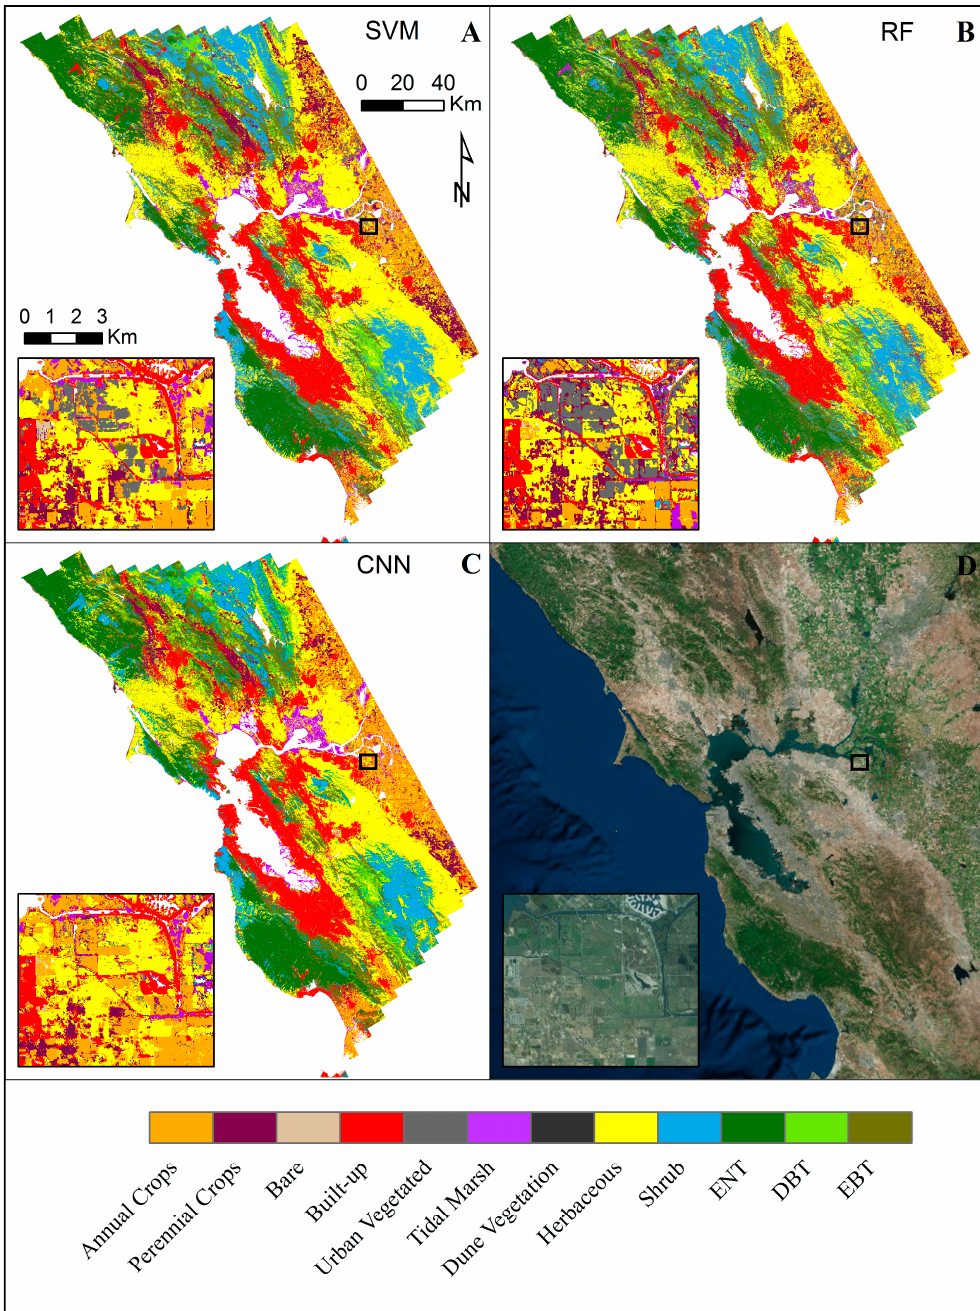
Figure 8. Classified land-cover maps for ( A ) Support Vector Machine; ( B ) Random Forests; and ( C ) Convolutional Neural Networks. White areas indicate pixels that were not classified (e.g., water, clouds, no data); ( D ) Natural color mosaic of imagery from June 2015. The insets show an example of the classifications in the Bay Area delta agricultural zone. This area is predominantly agricultural land with some urban areas. In this anthropogenic landscape, homogenous geometric shapes are dictated by property lines (Figure 8D). The RF classifier performs the worst with many areas with more speckle (i.e., more heterogeneity) of classes across the landscape. The RF and SVM maps both misclassified several parcels with Urban Vegetated that were